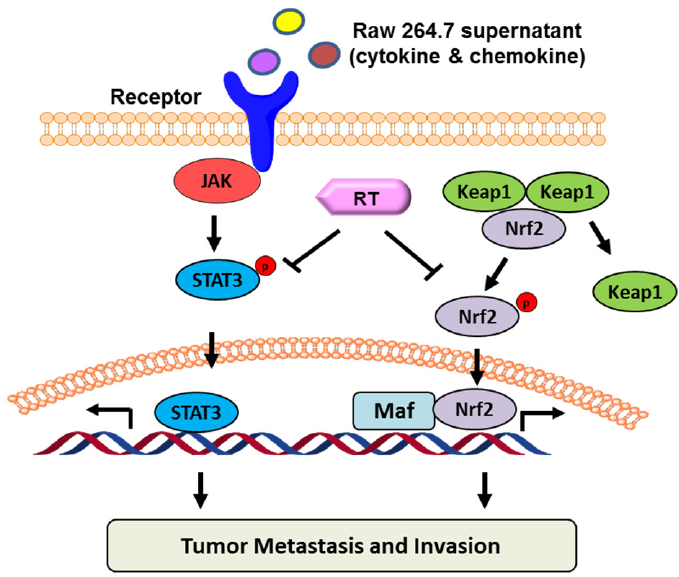
Figure 5. Proposed model of RT suppresses B16F10 cell migration and invasion.